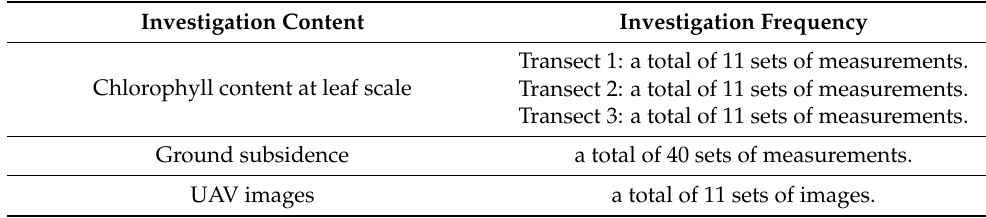
Figure 1. The layout of the transects and quadrats. Source: Built on the basis of the author’s field survey. Table 2. Investigation objects and investigation